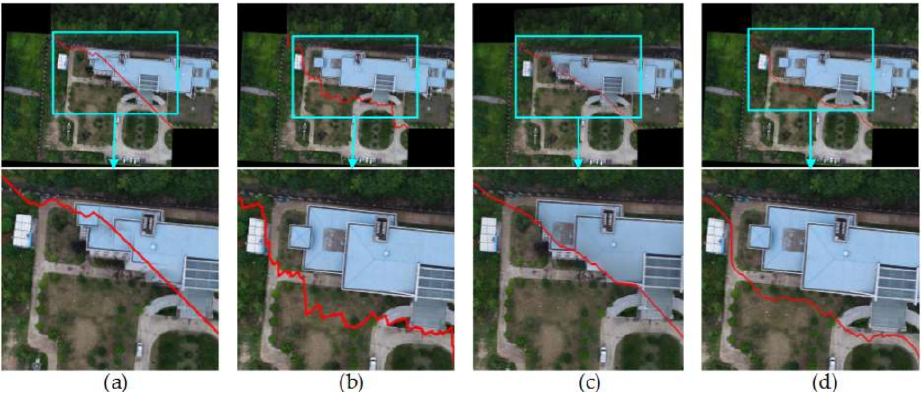
Figure 10. The seam-lines of different search methods for Figure 7c: ( a ) Dulapquet3-DP; ( b ) Dulapquet4-DP; ( c ) OpenCV-DP; ( d ) Our-Flow-DP.